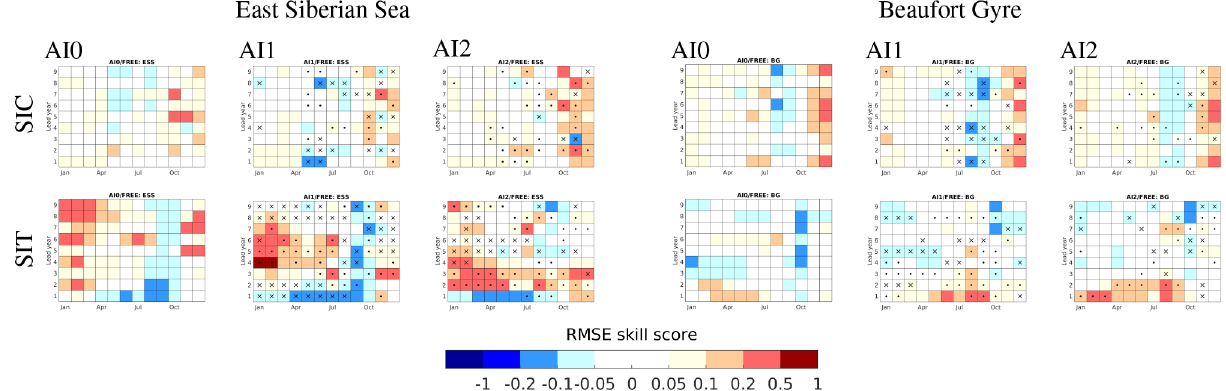
Figure 11. As Fig. 10 but for the Pacific shelf seas: East Siberian Sea (left) and Beaufort Gyre